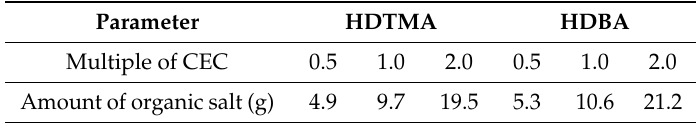
Table 1. The amount of dissolved cationic surfactants (g) required to prepare 30 g of 0.5, 1.0,